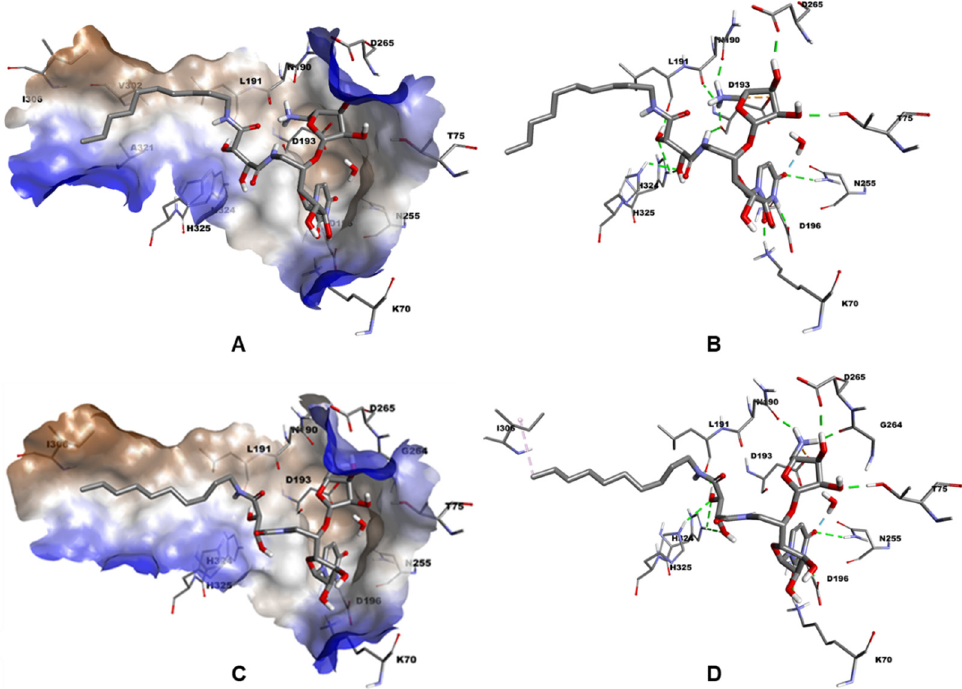
Figure 5. Predicted binding mode of compounds to MraY AA from docking in model 5CKR. ( A ) 3D